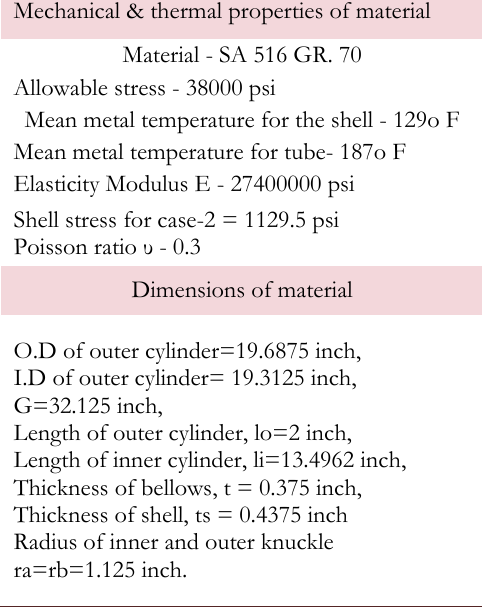
Table 1: Mechanical, thermal properties and Dimensions of material.